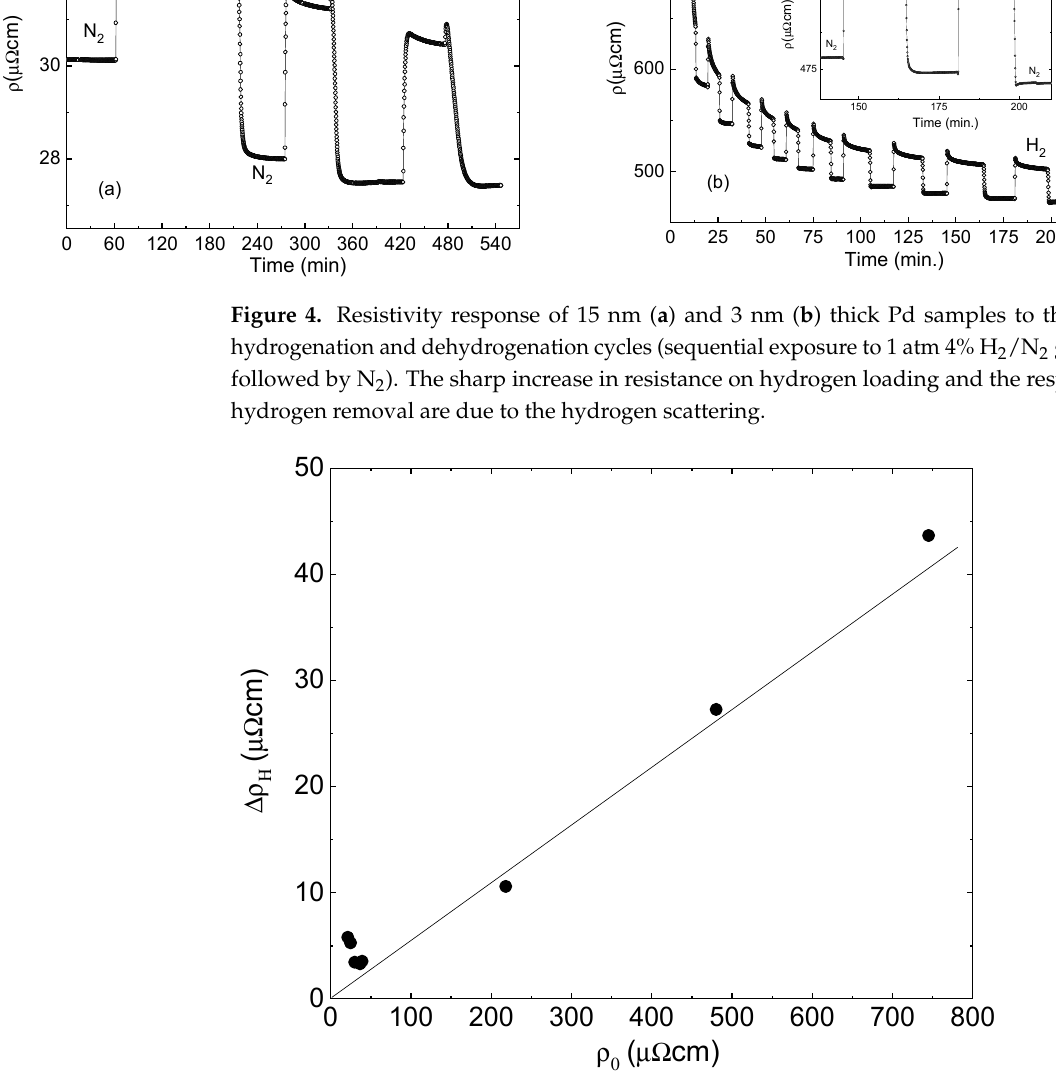
Figure 4. Resistivity response of 15 nm ( a ) and 3 nm ( b ) thick Pd samples to the sequences of hydro- genation and dehydrogenation cycles (sequential exposure to 1 atm 4% H 2 /N 2 gaseous mixture fol- lowed by N 2 ). The sharp increase in resistance on hydrogen loading and the respective drop on hydrogen removal are due to the hydrogen scattering.